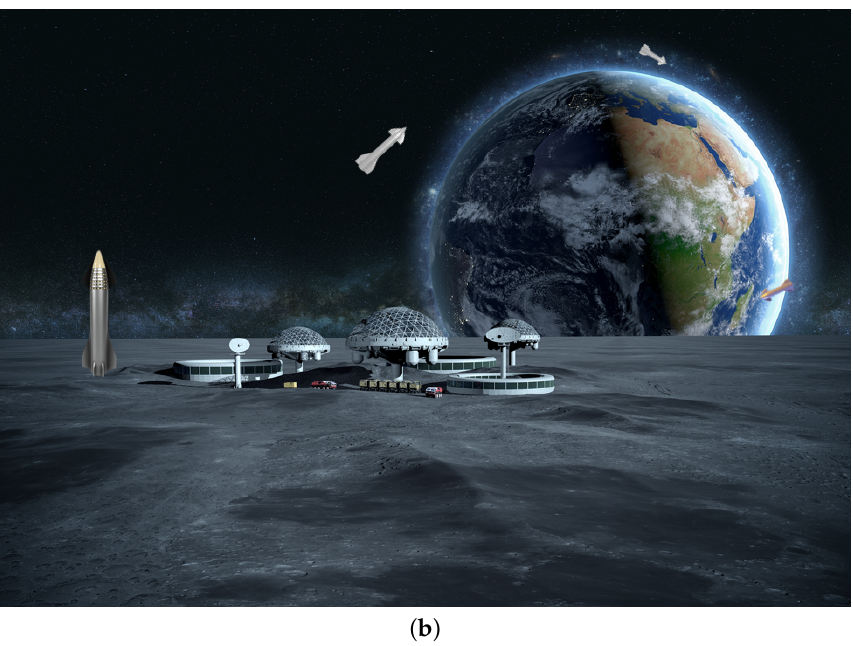
Figure 8. Illustration of foundation of: ( a ) Mars city; ( b ) Moon base with massive connected spaceships.